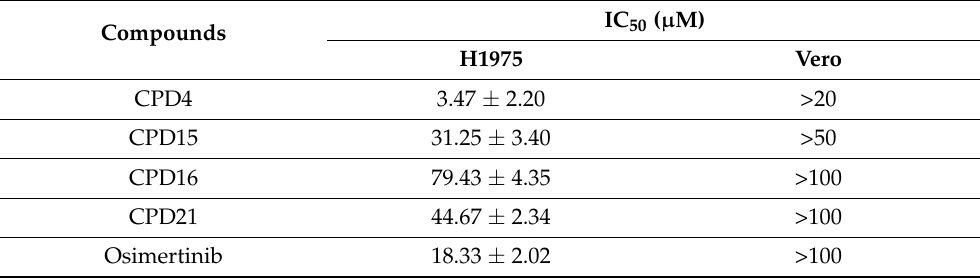
Table 3. Cytotoxic effect of CPD derivatives and osimertinib on the H1975 and Vero cell viability represented as IC 50